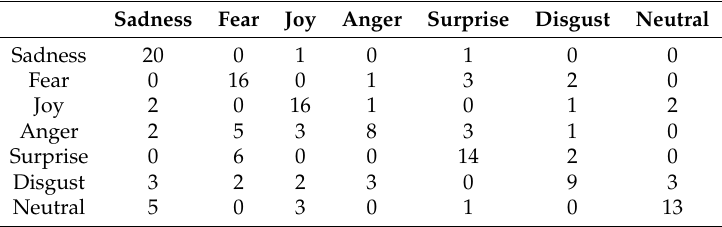
Table A6. P6 actor confusion matrix from the RekEmozio dataset in the second phase.